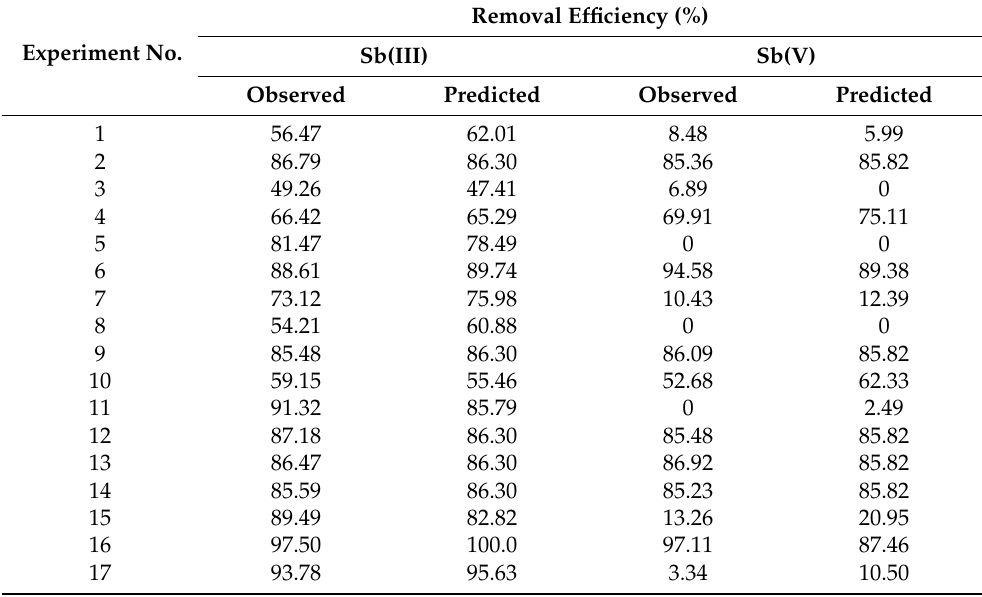
Table 4. Comparison of observed and predicted antimony removal efficiency.